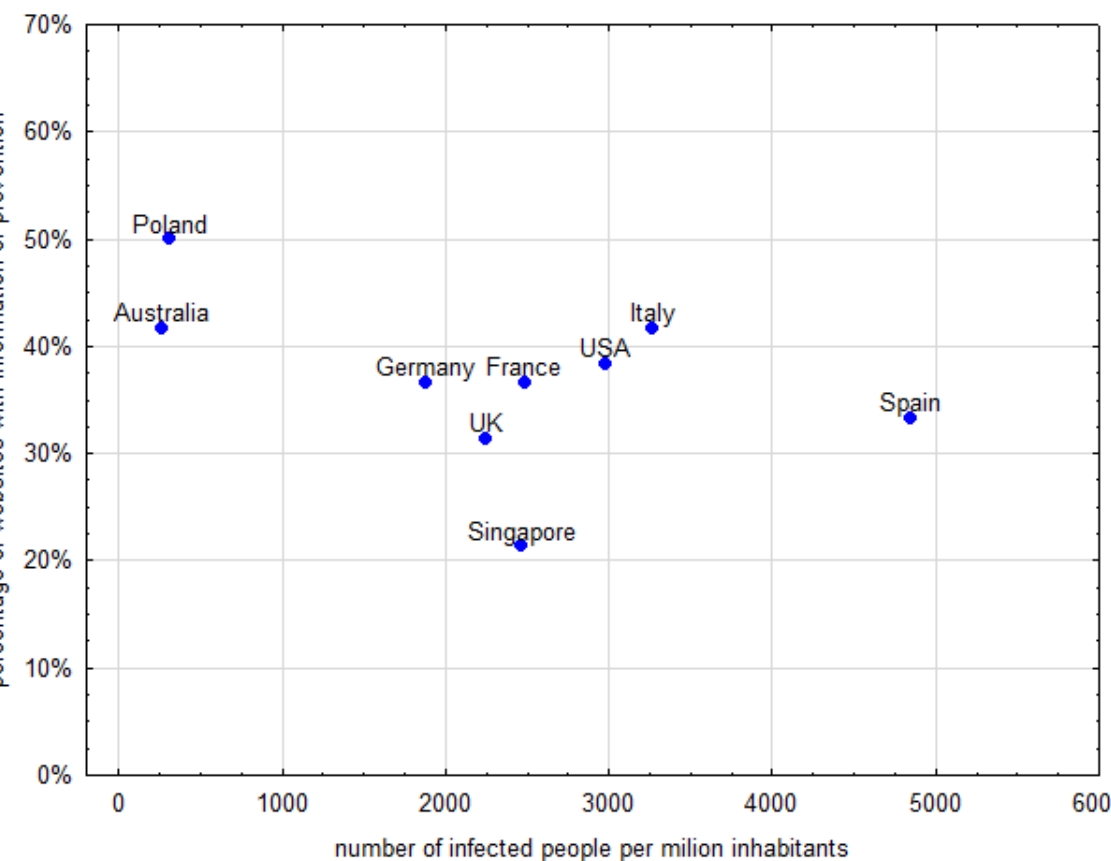
Figure 4. Change in a percentage of websites with information on prevention with number of infected people per million inhabitants.